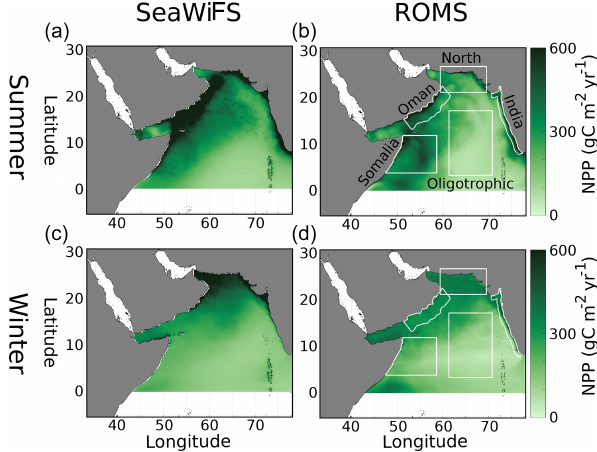
Figure 1. Vertically integrated net primary production in the Ara- bian Sea (gCm − 2 yr − 1 ) from the VGPM algorithm (Behrenfeld and Falkowski, 1997) for SeaWiFS data (years 1997–2010) (a,c) and model output (b,d) for summer (JJAS, a,b ) and winter (DJFM, c,d ) monsoons. White boxes in (b,d) denote regions of analysis in the